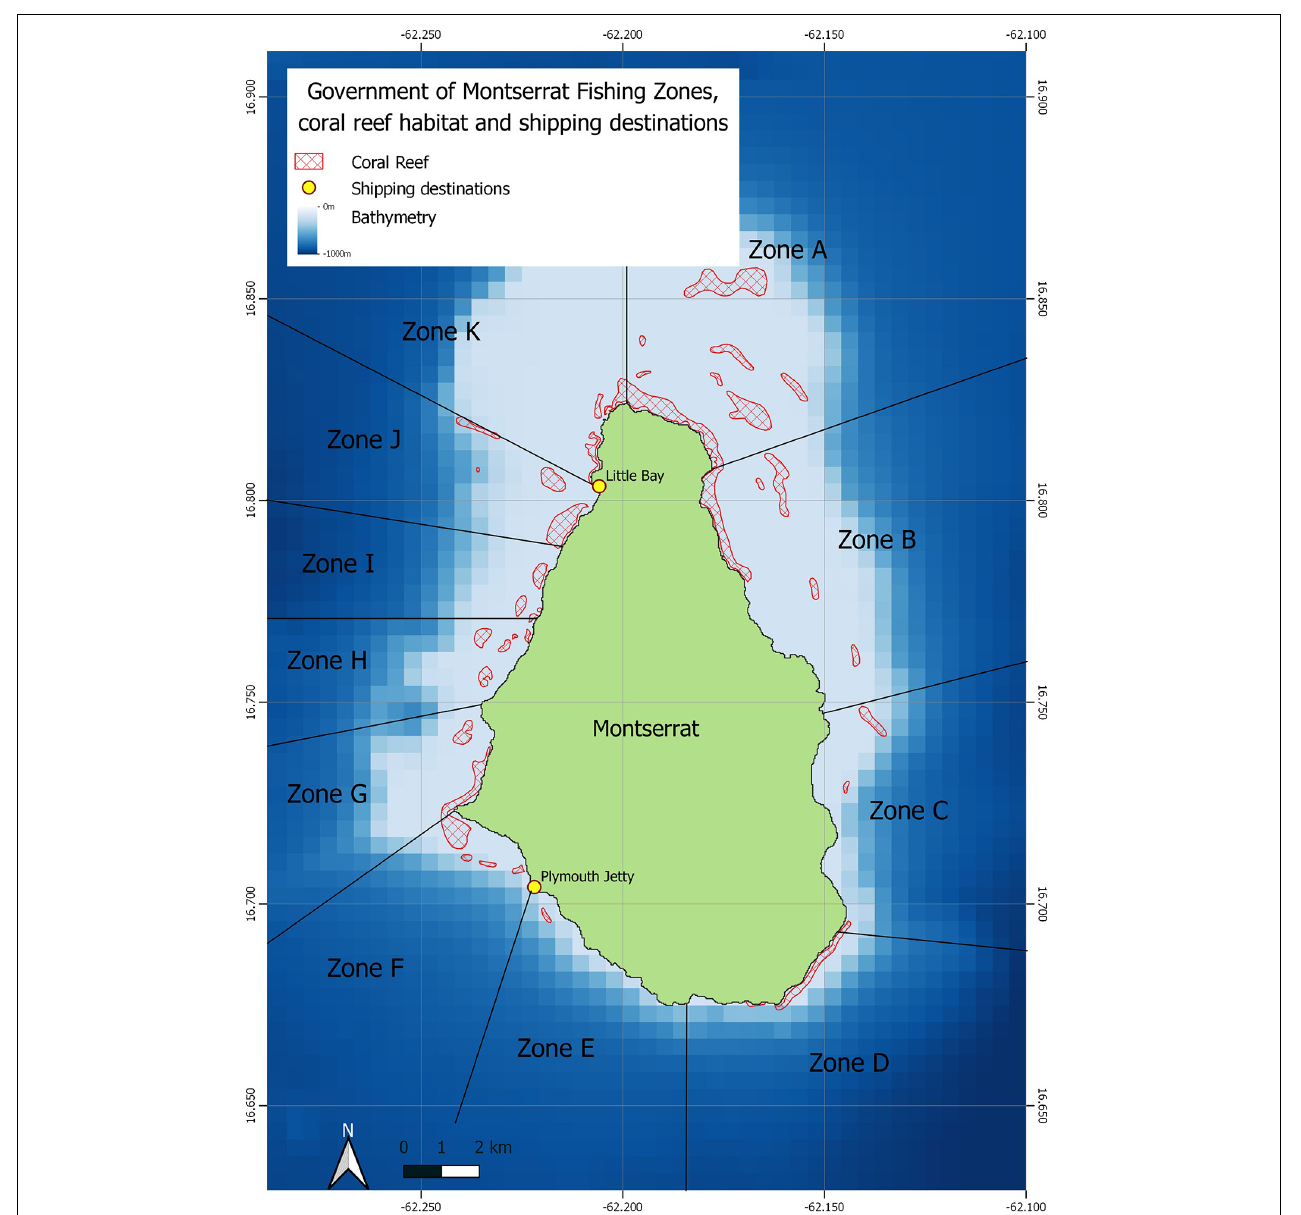
FIGURE 1 | Government of Montserrat Fishing Zones and shallow-water coral reef